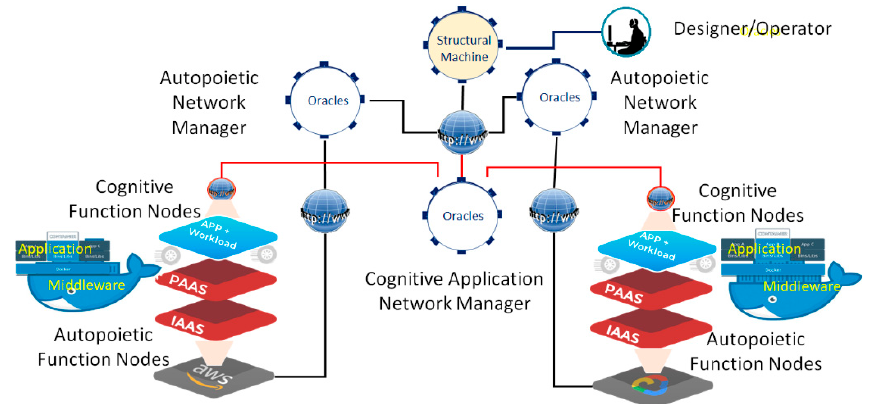
Figure 6. A self-regulating application implemented as a knowledge network managed by autopoietic and cognitive network regulators. (See the video for how autopoiesis and cognition improve sentience, resilience, and intelligence of an application (https://youtu.be/WS6cfFN4X3A accessed on 30 December 2021).